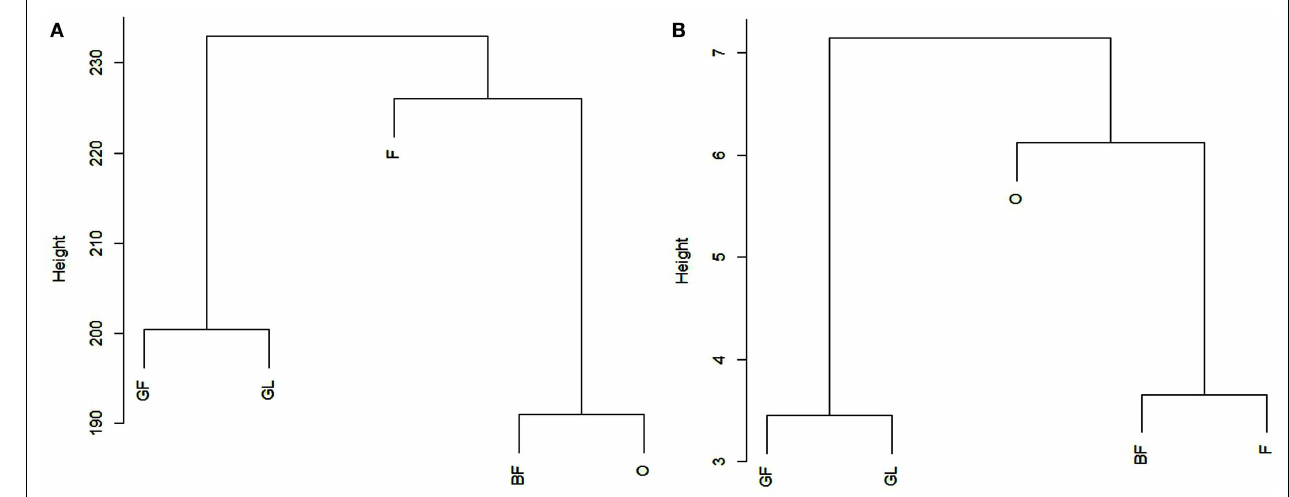
considered (miRNA ∗ -related reads are included). In (B) , the analysis included only those loci where the most frequent read was the same in all the samples. BF, pink; F, bloom; GF, swollen flower bud; O, half-inch green; GL, swollen leaf